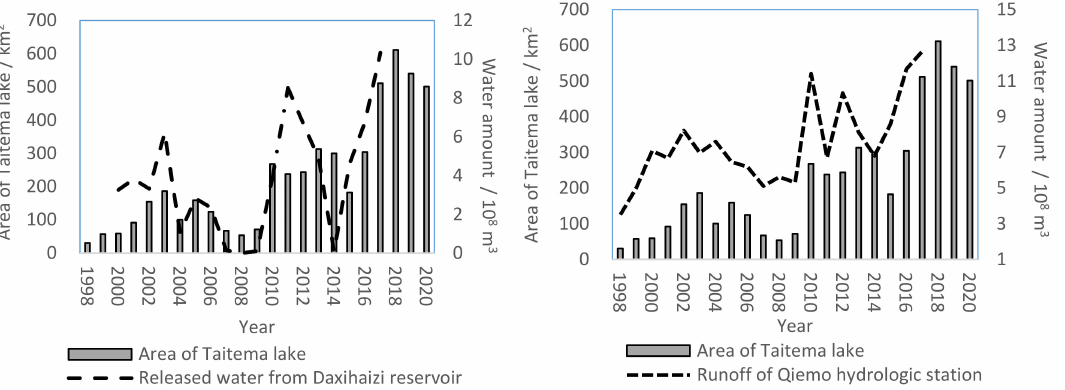
Figure 2. Variation in the water volume of the two rivers and the area of Taitema